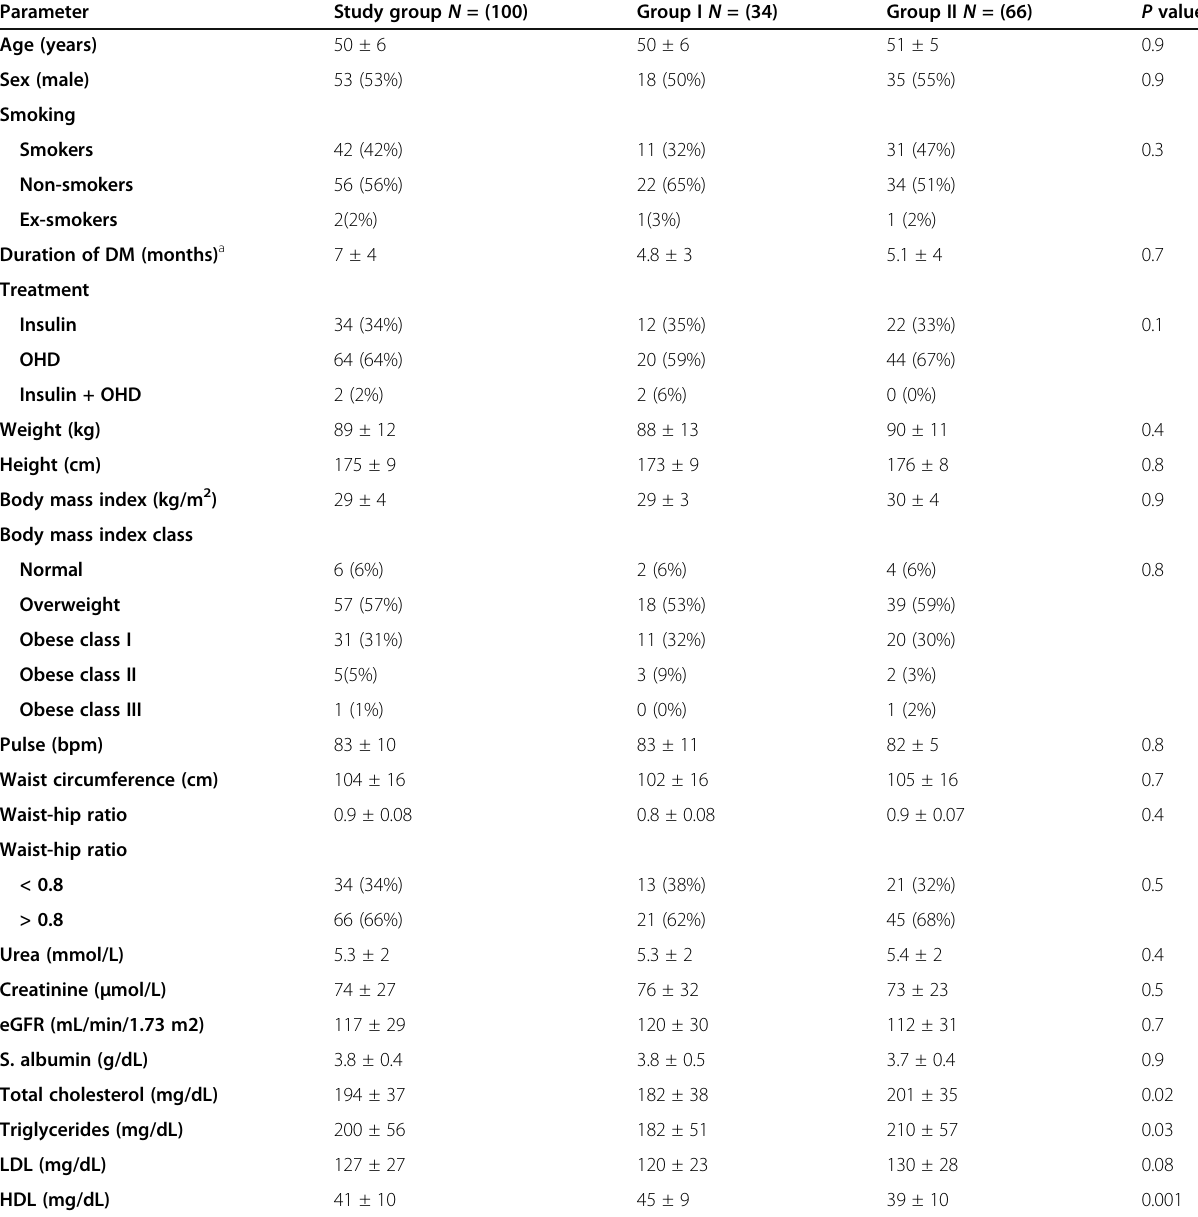
Table 1 Demographic, clinical and laboratory characteristics of the study group classified according to glycated HbA1c level